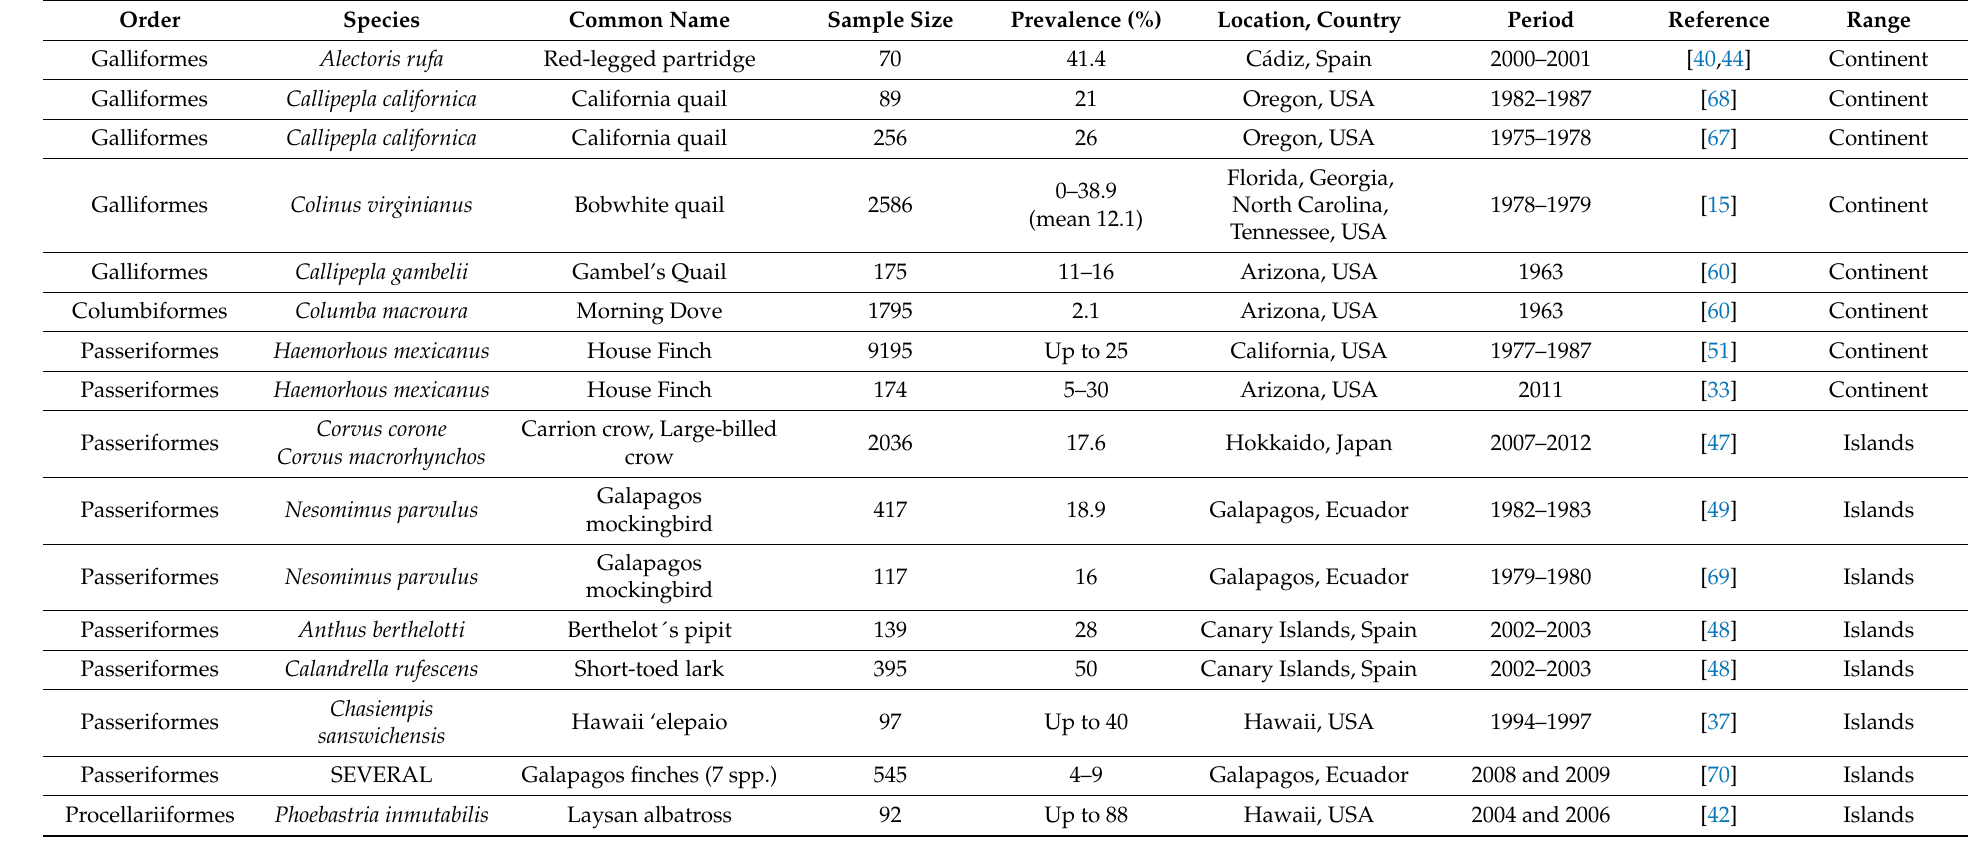
Table 2. Prevalence of avian poxvirus in surveys that are not identified by authors as epizootics or